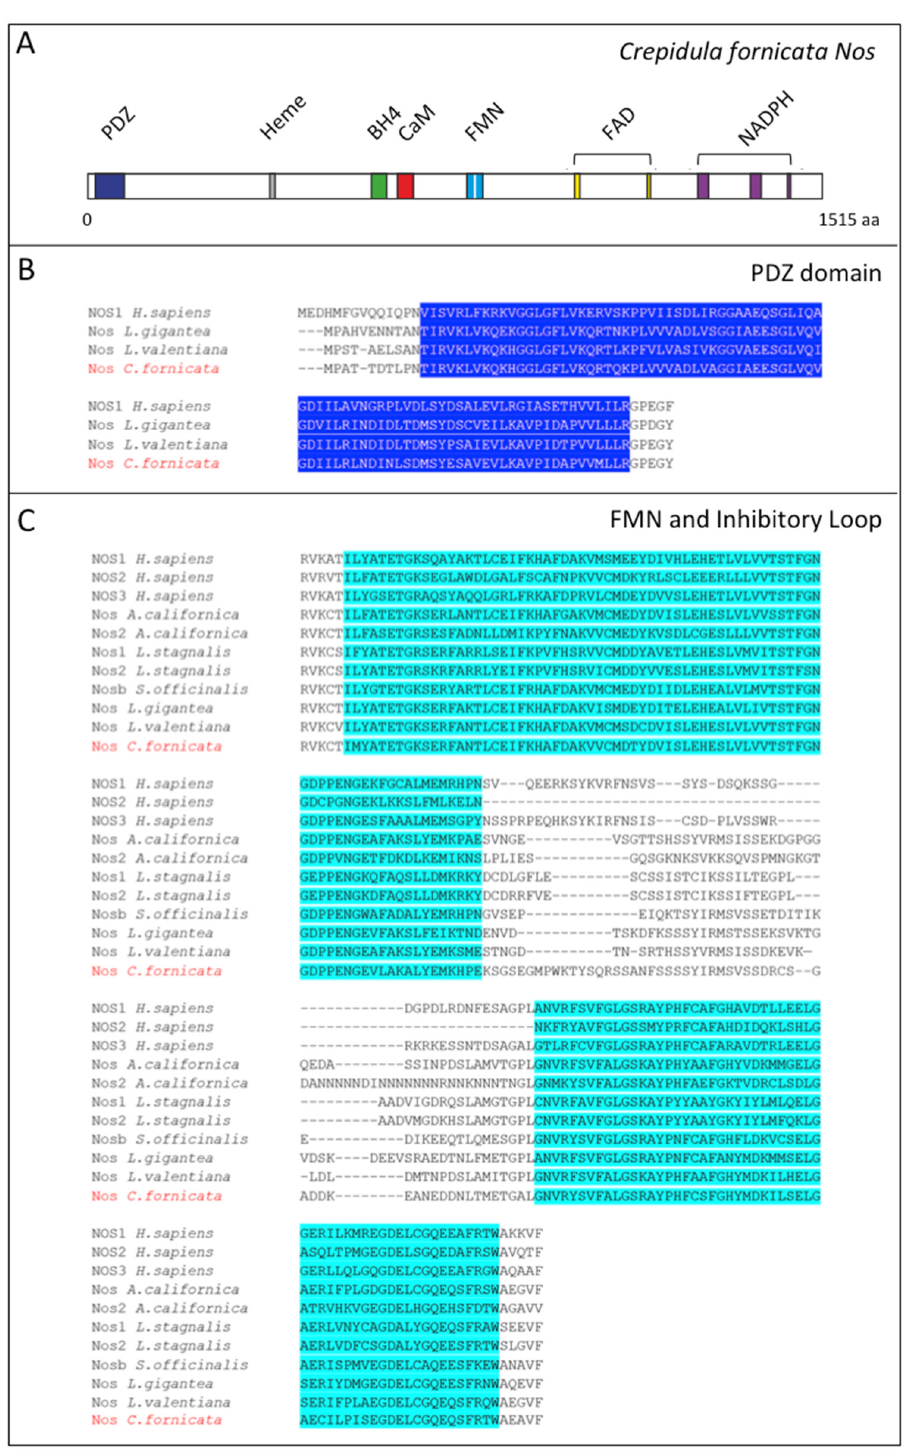
Figure 1. Protein domains characterization of Cfo-Nos ( A ) Schematic representation of Nos protein domains in slipper shell snail C. fornicata . Colour code: PDZ in blue, Heme in grey, BH 4 in green, CaM in red, FMN in light blue, FAD in yellow, and NADPH in purple. The uncoloured sequence within the FMN domain is the inhibitory loop. ( B ) PDZ domain in Cfo -Nos as revealed in the alignment with Homo sapiens NOS1, L. gigantea and L. valentiana Nos. ( C ) FMN domain and the inhibitory loop in Cfo -Nos as revealed in the alignment with Homo sapiens NOS1, NOS2 and NOS3; Aplysia californica Nos and Nos2; Lymnaea stagnalis Nos1 and Nos2; Sepia officinalis Nosb; L. gigantea and L. valentiana Nos. The displayed alignment is focused on the FMN domain and the inhibitory loop.